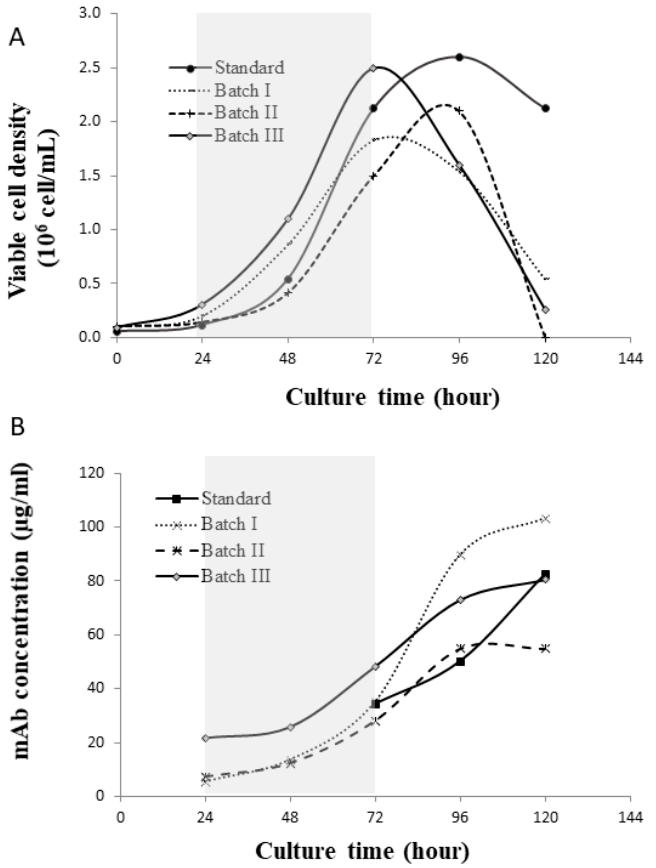
Figure 4. Cell culture performance ( A ) viable cell density; ( B ) mAb concentration. The exponential growth phase is shaded in grey.